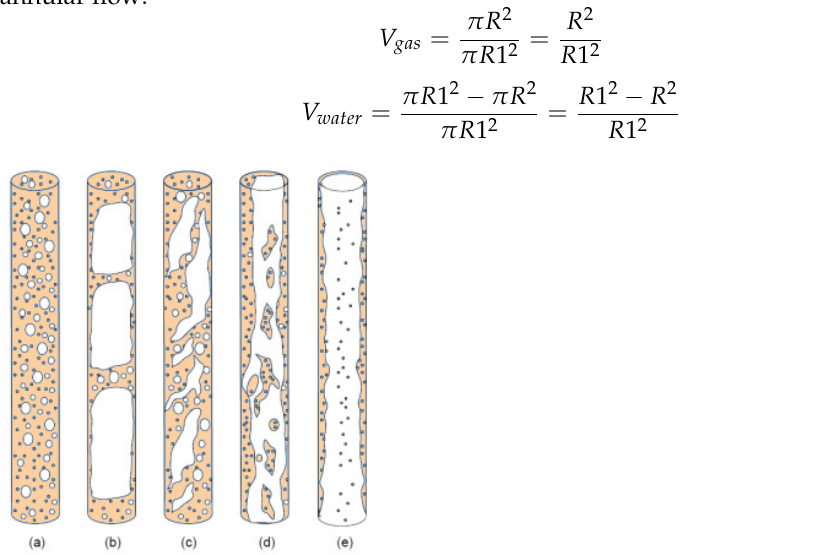
Figure 1. ( a ) Bubble flow, ( b ) Plug slug flow, ( c ) Foam flow, ( d ) Annular streak flow, ( e ) Annular flow.